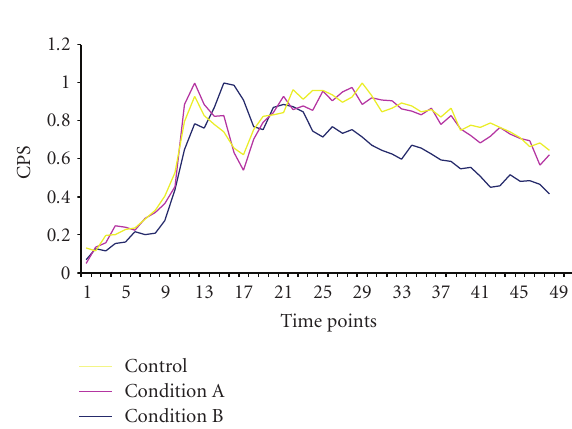
Figure 2: The trajectories of one gene in 3 conditions. Control: TSBDC, Condition A: TSBDC + 50ug/mL FeCl 3 Condition B: TSBDC + 400 ug/mL EDDA.